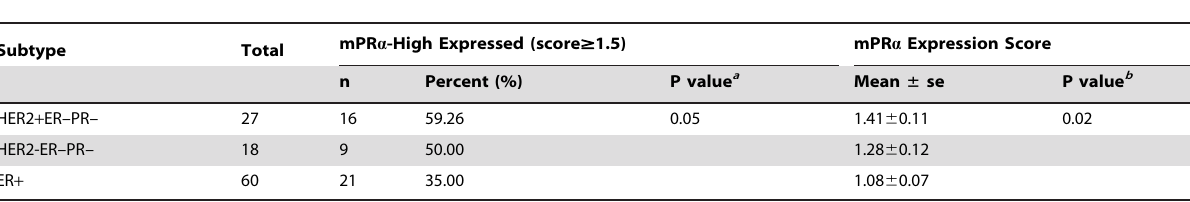
Table 3. Correlation between mPR a expression and molecular subtypes of breast